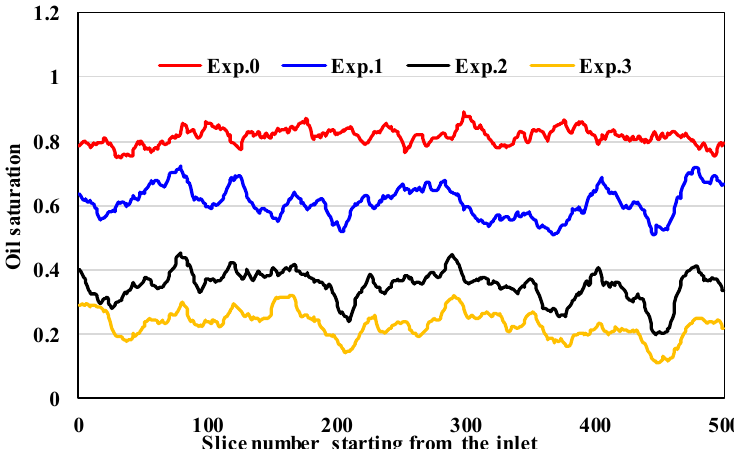
Figure 8. Macro-/micro-/total-porosity versus two-dimensional slice.